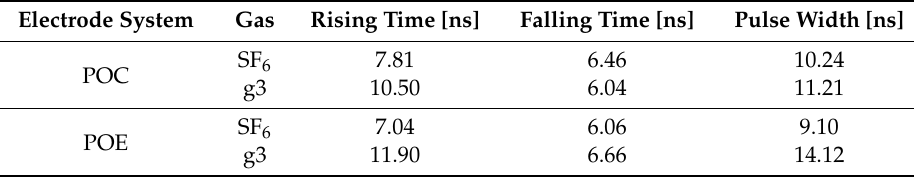
Figure 5. PD pulse and its FFT in SF 6 and g3 in the POE. ( a ) In time domain; ( b ) In frequency domain. Table 2. Comparison of pulse parameters.